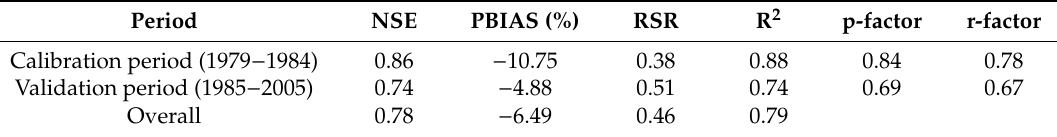
Table 7. Performance values of the SWAT model for the calibration and validation periods.